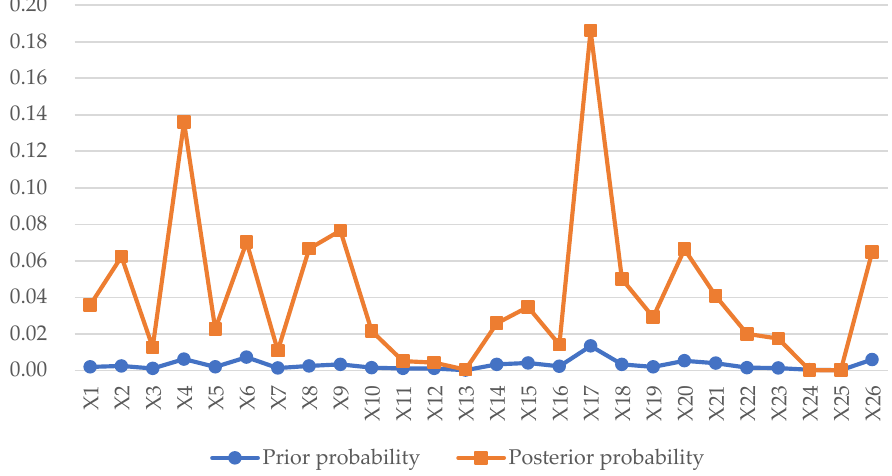
Figure 7. The comparison results of the prior probability and posterior probability of the root node.